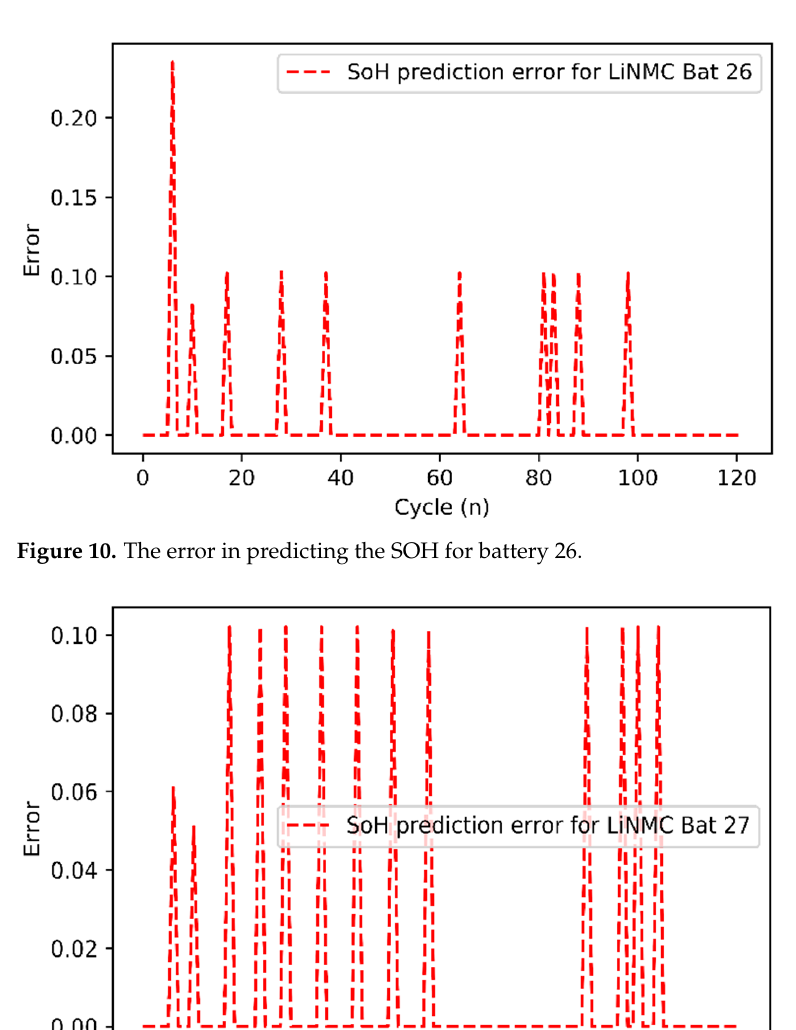
Figure 9. The error in predicting the SOH for battery 25.